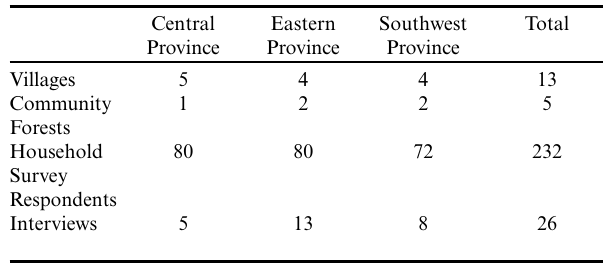
Table 1 . Summary of data